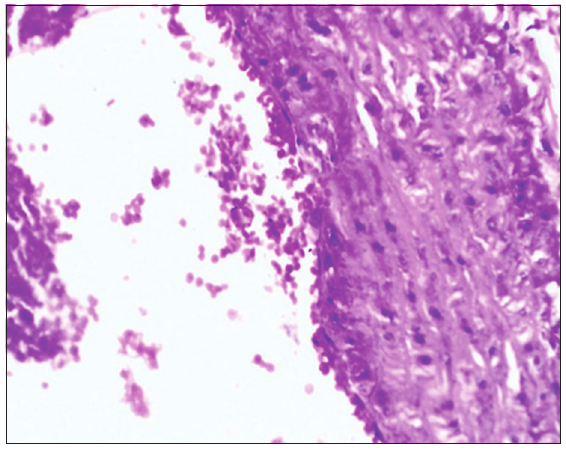
Figure-7: Aorta (Group IV) section showing mild endothelial degeneration with adhered erythrocytes (H and E, 100×).